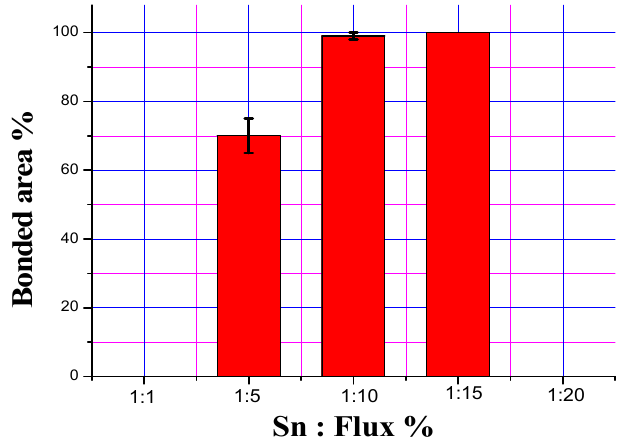
Figure 8. Bimetallic interfacial bonded areas in bimetallic specimens as a function of Sn-to-flux ratios.